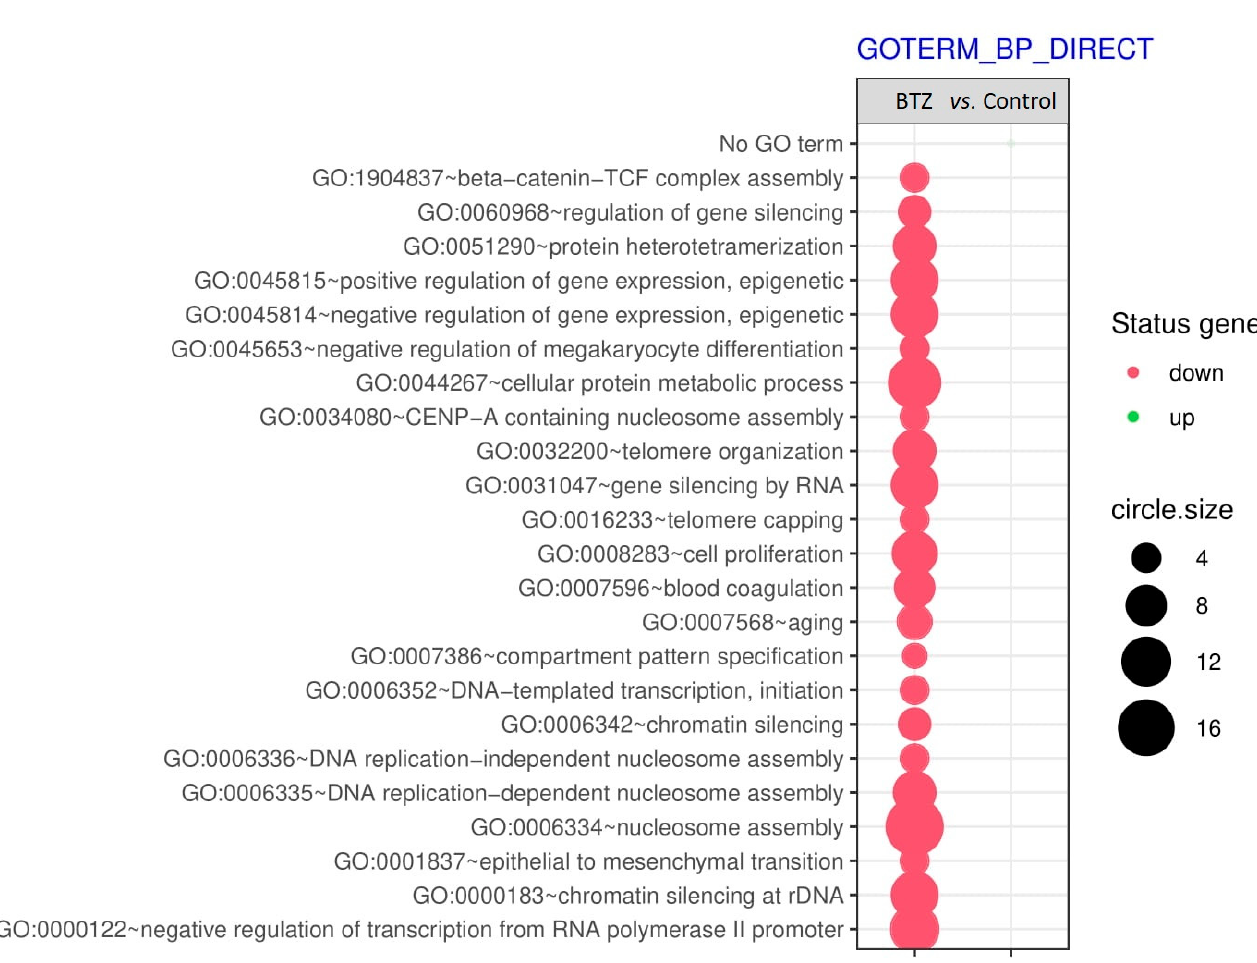
Figure 2. Bubble plot of biological processes according to GO classification.